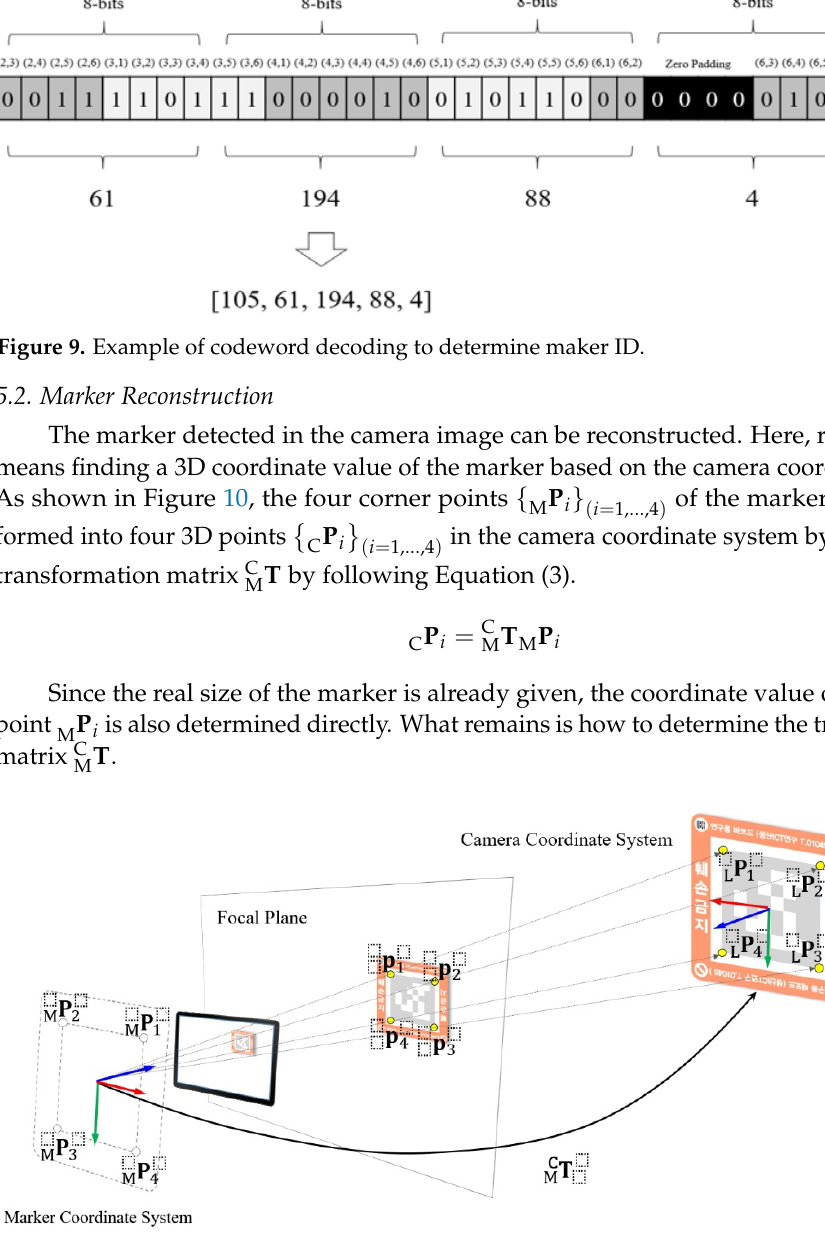
Figure 11. Concept of marker recovery in world coordinate system using Tango tracker. 5.3. Reconstruction Refinement The Tango tracker typically shows very accurate localization performance in a small area (less than 5 square meters). However, as the moving distance increases, the accumu- lative positional error also increases exponentially. This may seriously affect the accuracy of the marker registration, which is why an additional optimization technique is needed to minimize the accumulative positional error. To solve this problem, we applied bundle adjustment (BA) [31], which is a well-known photogrammetric optimization algorithm. In this study, we also utilized the constraints that the marker has a rigid body and the size of the marker is given. The distance between the markers is usually at least 5 m. Therefore, there is no case in which two markers are simultaneously photographed in one image. Of course, it is also im- possible to perform BA using only the marker scenes. In this paper, we propose a hybrid BA optimization using both natural feature points and marker corner points. For the scene